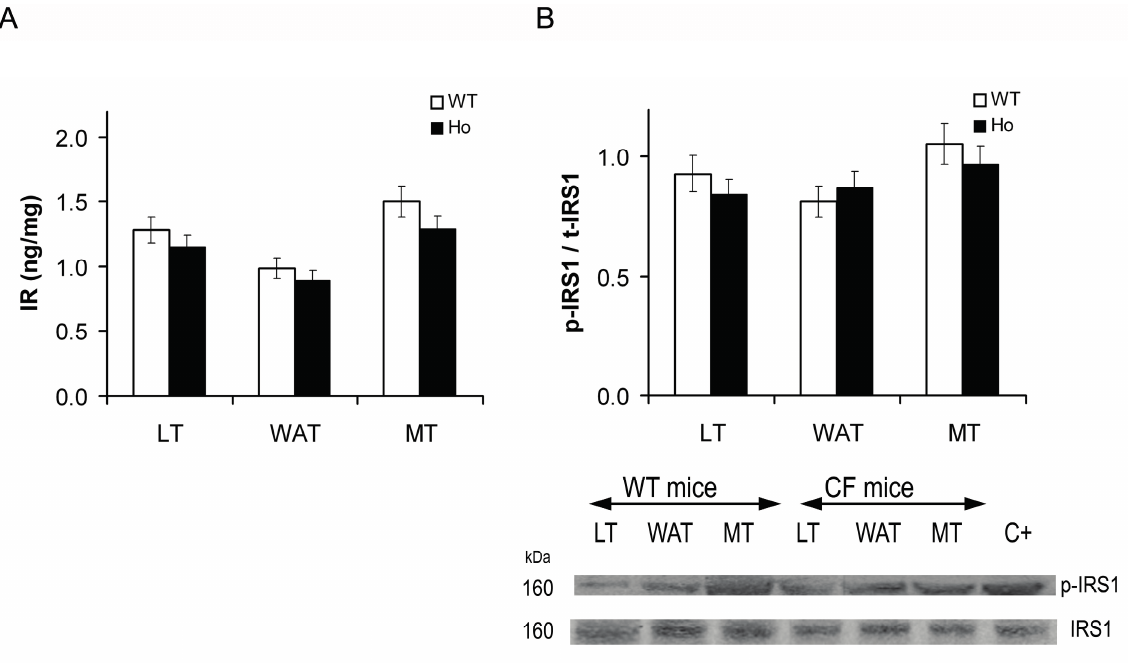
Figure 8. Insulin receptor content and p-IRS1/t-IRS1 ratio in mouse tissues. Total insulin receptor (IR) content ( A ), and activated [Y941]/total insulin receptor substrate type 1 (IRS1) ratio (p-IRS1/t-IRS1) ( B ) in 129/FVB CF-affected mice (Ho) and in their wild-type littermates (WT) in baseline condition in liver (LT), white adipose (WAT) and skeletal muscle tissues (MT). ( A ) IR was quantified using an ELISA kit and expressed in ng/mg of total protein content. IR content in CF mice was similar to WT mice in each tissue; ( B ) IRS1 was quantified by Western immunoblotting after immunoprecipitation, p-IRS1/ t-IRS1 content in CF mice was similar to that in WT mice in all tissues. Beneath is a representative immunoblot showing tyrosine 941 phosphorylated IRS1 and total IRS1. C+: positive control. The bars represent the mean ±